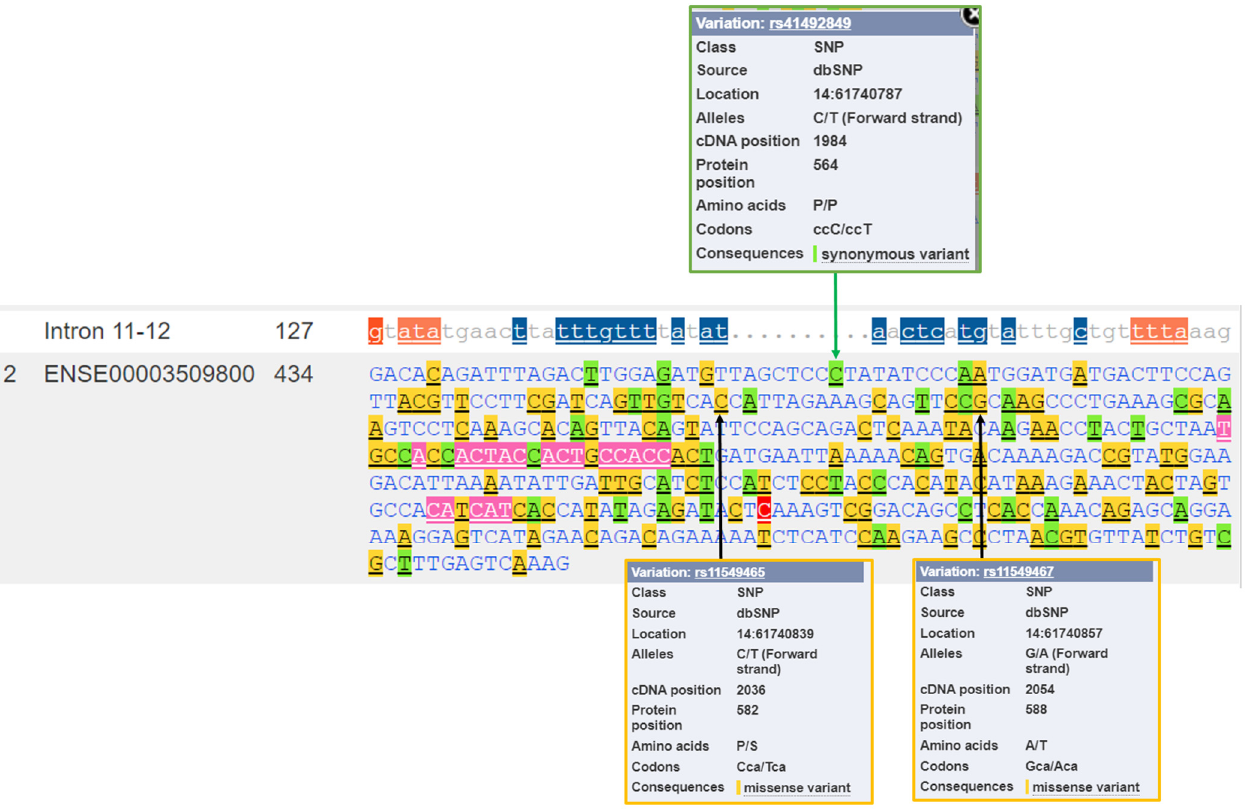
Figure 4. HIF1A nucleotide sequence of exon 12 with marked genetic variants. The green arrow denotes a synonymous variant C > T at the proline residue at position 564 (P564); the site of hydroxylation by HIF prolyl hydroxylase EGLN1. The black arrows denote missense variants at the protein positions 582 and 588. Legend: P/S: Pro/Ser; A/T: Ala/Thr.